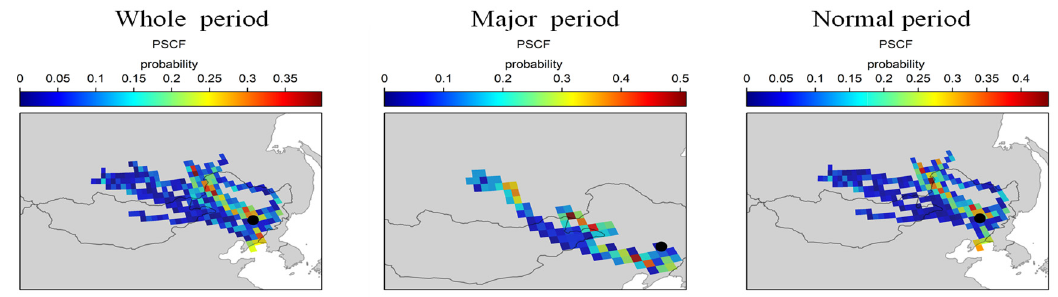
Figure 7. Potential source contribution factor weights (PSCF) distribution characteristics of PM 2.5 in di ff erent periods in Changchun during the 2018 Spring Festival.